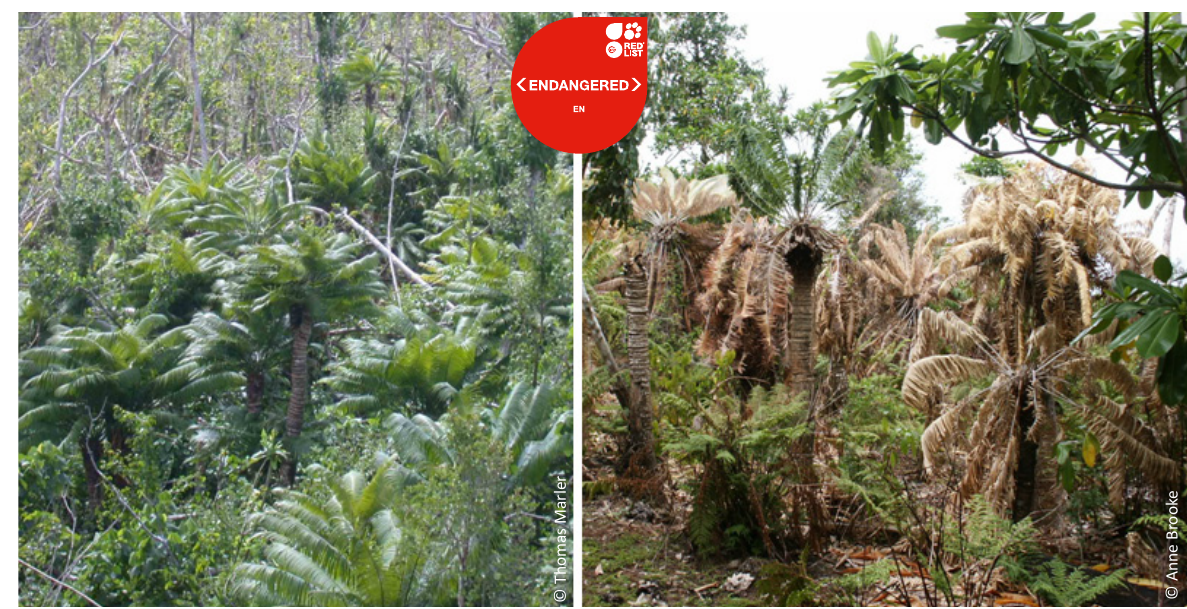
Image 1. Healthy Cycas micronesica trees (left) were the most abundant tree on the island of Guam prior to the invasion of several exotic specialist pests. Aulacaspis yasumatsui invaded Guam in 2003, and heavy infestations rapidly began to kill trees (right).